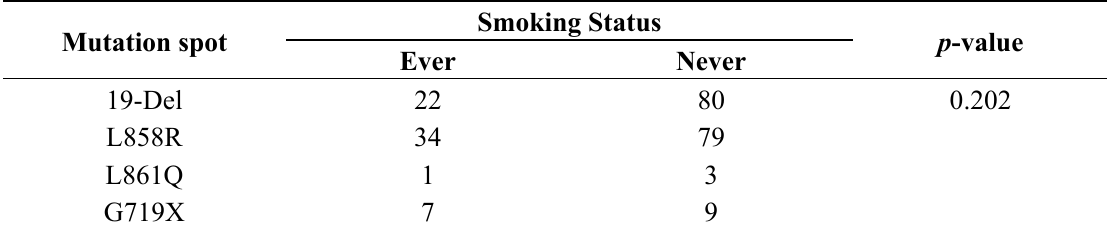
Table 3. Subtypes of TKIs sensitive EGFR mutations according to the smoking status.